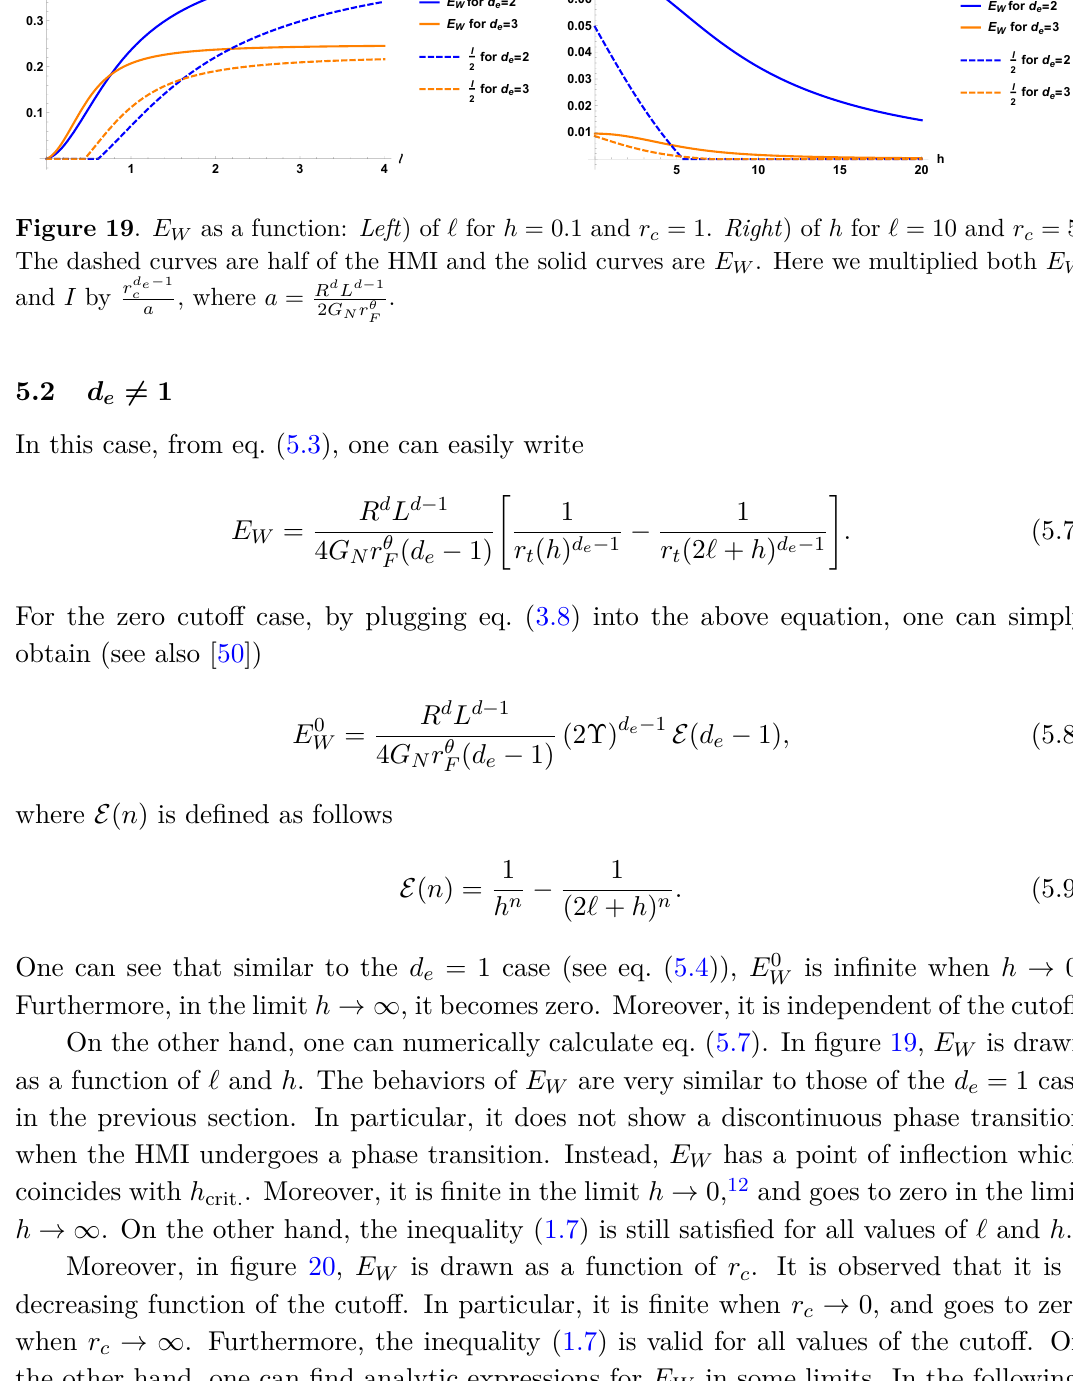
. Here we multiplied both E W